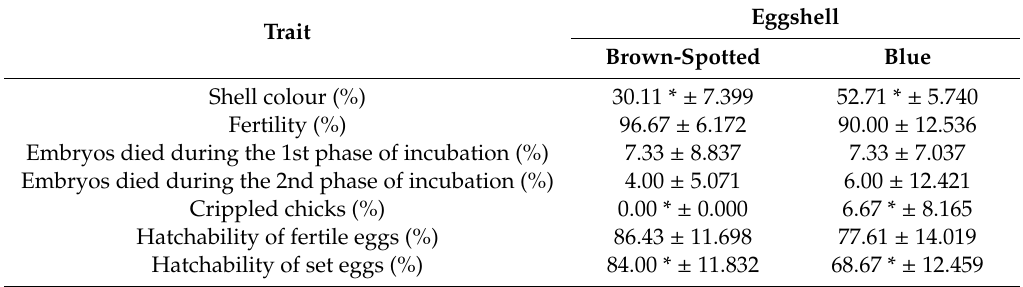
Table 3. The hatching results of Japanese quails’ eggs depending on their shell colour (mean ±